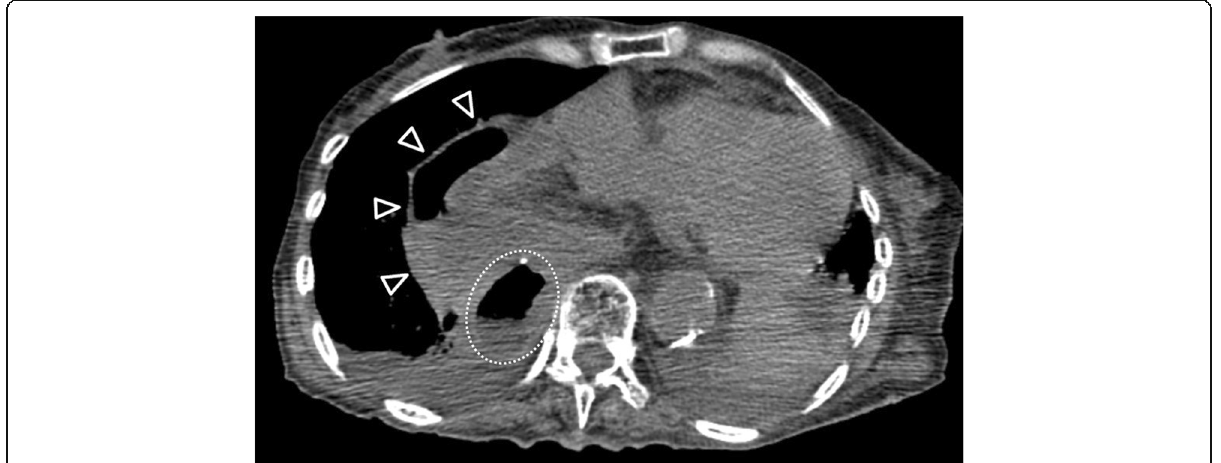
Fig. 1 Computed tomography images. Non-contrast computed tomography revealing digestive tract prolapse into the right side of the mediastinum, which is distended with air and fluid (arrow heads). A moderate amount of pleural effusion is collected in both of the thoracic cavities. The gastric conduit is indicated in the circle